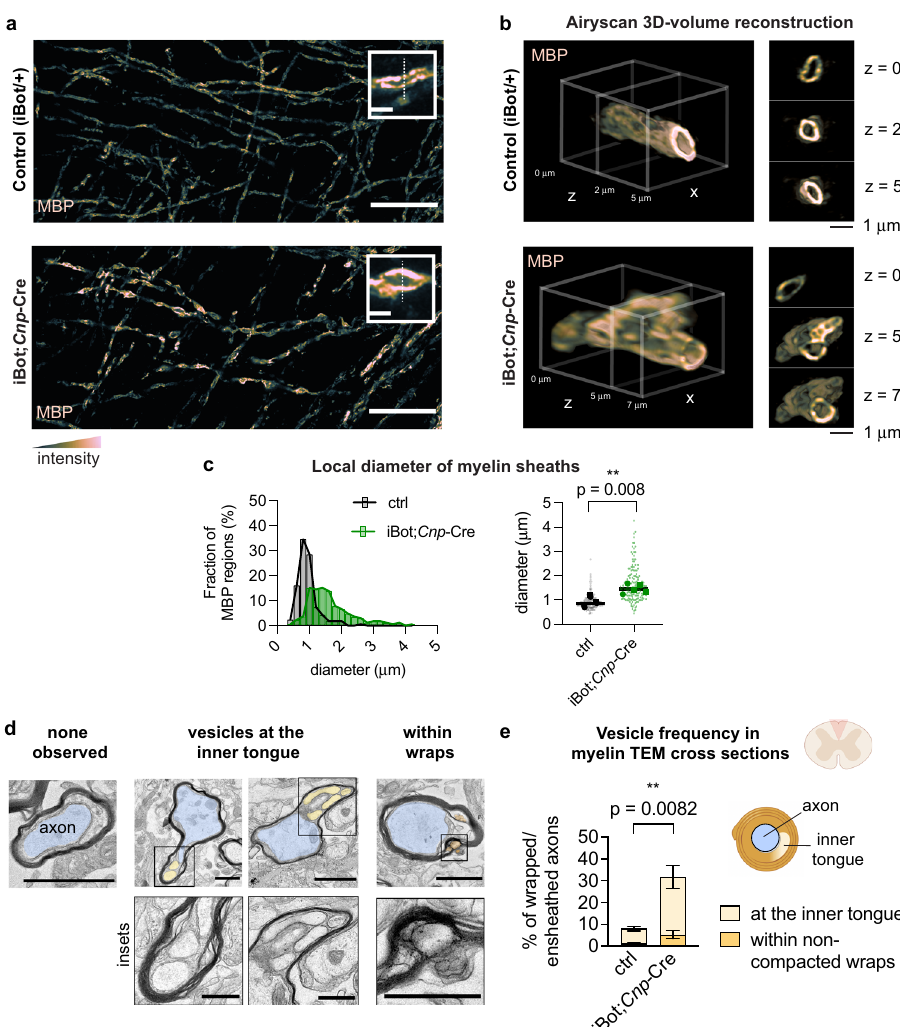
Fig. 5 | Vesicles accumulate at the inner tongue of myelin sheaths following inactivation of VAMP2/3. a Super-resolution (Airyscan confocal) images of P12 mouse cingulate cortex from control (top) and iBot; Cnp- Cre (bottom) littermates immunostained for MBP. Scale bar, 20 μ m (inset, 2 μ m). b 3D reconstructed Air- yscan confocalz-stack ofa myelinatedaxon cross section from a control (top)and iBot; Cnp -Cre (bottom) mouse spinal cord immunostained for MBP. See also Sup- plementary Videos 3 and 4. c Quanti fi cation of sheath diameter on thresholded regions of high MBP intensity from a . Squares and circles denote males and females, respectively. Mean sheath diameter±SEM: control 0.89±0.13 μ m from 161 regions quanti fi ed within n =3 biologically independent replicates; iBot 1.46±0.08 μ m from 165 regions quanti fi ed within n =5 biologically independent replicates. See Supplementary Fig. 11 for quanti fi cation methodology. Statistical